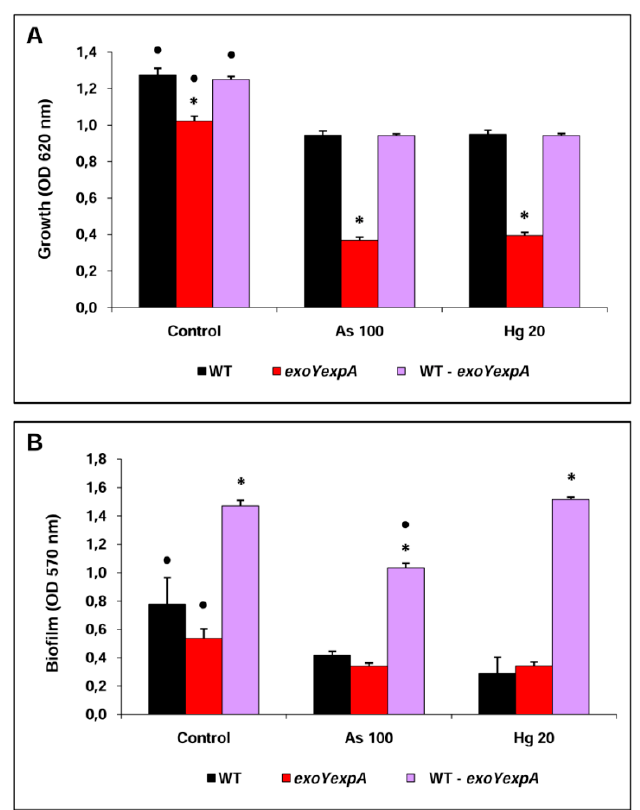
Figure 3. Bacterial growth ( A ) and biofilm formation ( B ) of individual and co-culture S. meliloti strains in control and exposed to heavy metal conditions. Bars marked with * indicate statistic differences among individual or co-culture strains for the same condition according to Fisher’s LSD test ( P < 0.05). Bars marked with • indicate statistic differences between conditions for a given strain according to Fisher’s LSD test ( P < 0.05).